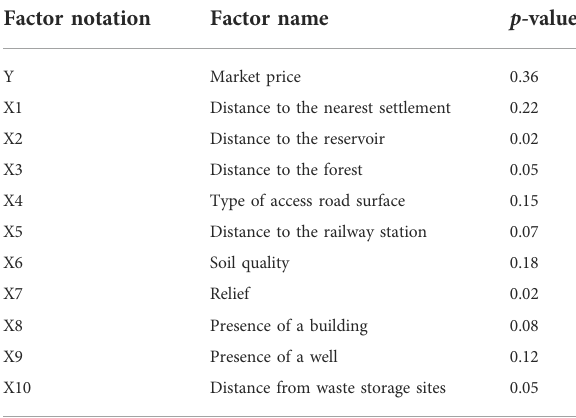
TABLE 2 p -values according to the Kolmogorov-Smirnov goodness- of- fi t test.